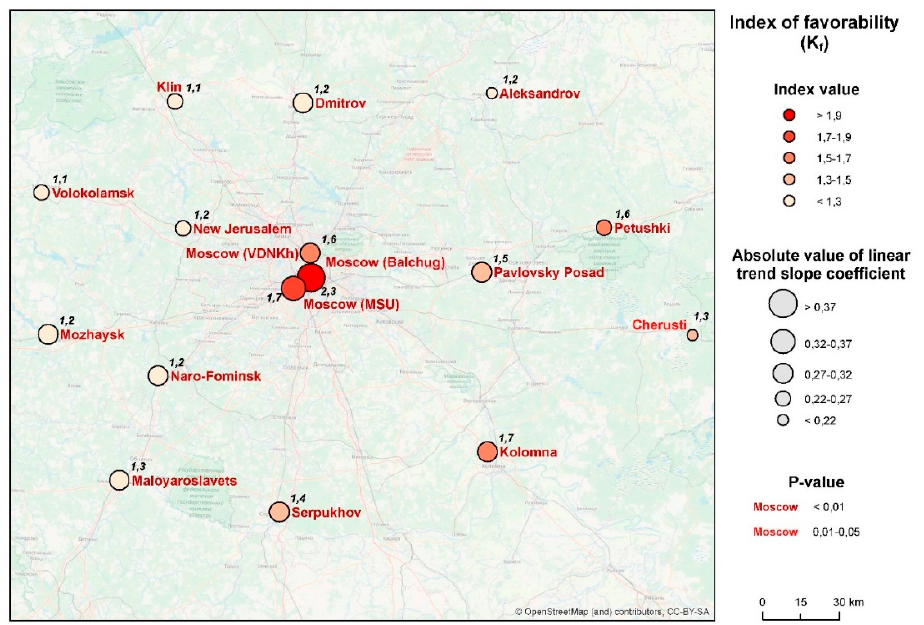
Figure 10. Spatial distribution of changes in the K f (index of favorability).